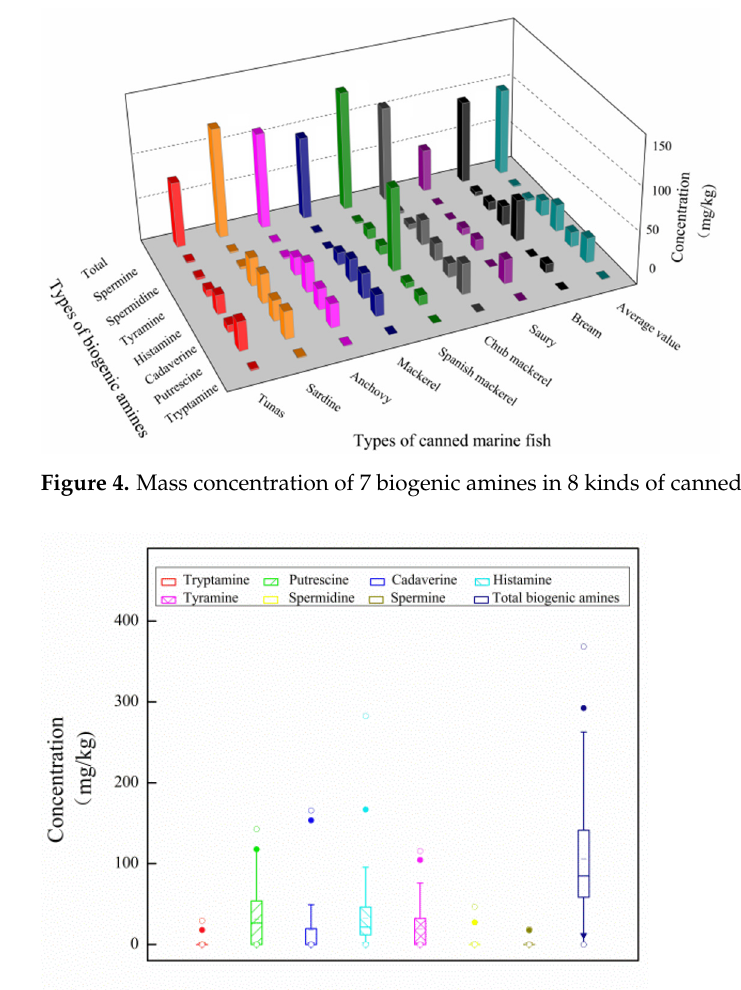
Molecules 2022 , 27 , x FOR PEER REVIEW Figure 5. Box diagram of concentration distribution of 7 biogenic amines. Figure 5. Box diagram of concentration distribution of 7 biogenic amines. Figure 5. Box diagram of concentration distribution of 7 biogenic amines.